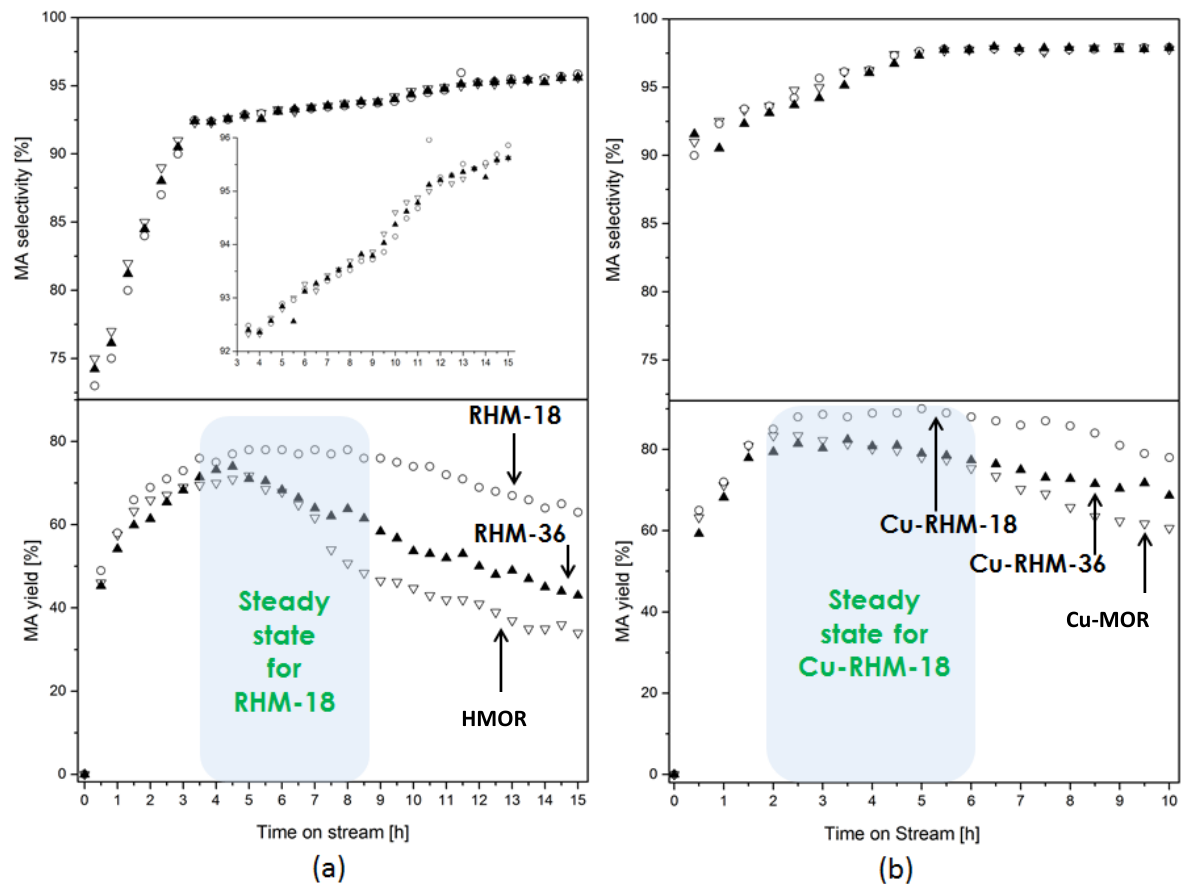
Figure 6. ( a ) MA yield and selectivity in DME carbonylation using RHM catalysts. ( b ) MA yield and selectivity in DME carbonylation using 1 wt% Cu-RHM catalysts. Open circle: RHM-18, filled triangle: RHM-36, open triangle: HMOR. Reaction conditions: 500 mg catalyst, 220 ◦ C, 100 mL min − 1 gas flow of DME/CO/N 2 = 1.3/92.7/5.0%, 7 bar, GHSV = 6711 h − 1 . Data reported with an estimated error corresponding to ± 2%.